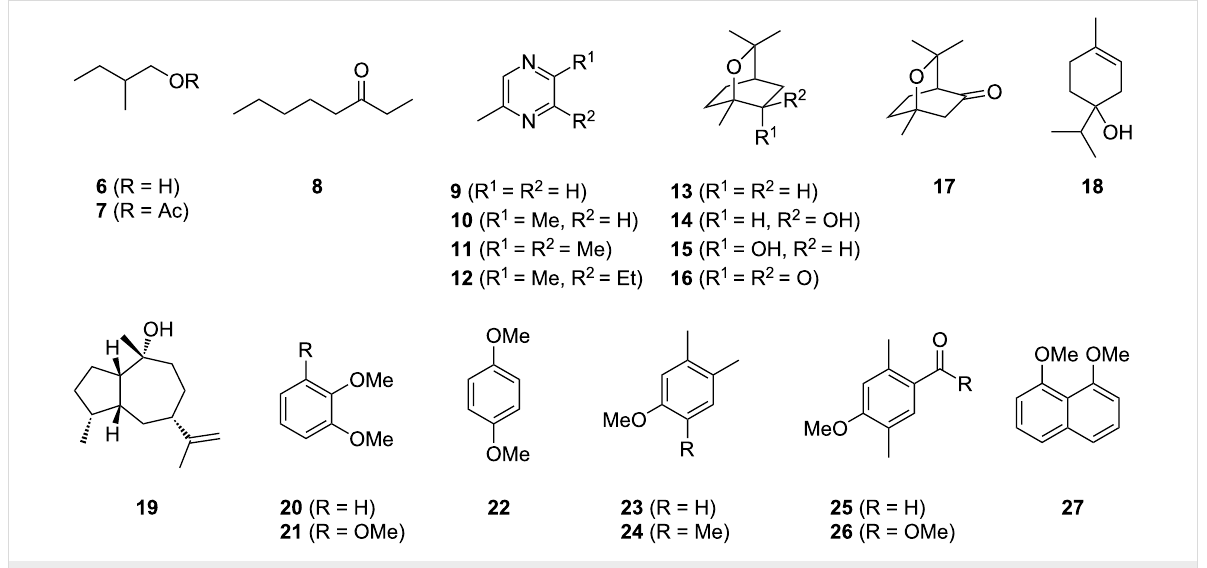
Figure 3: Volatiles from Hypoxylon griseobrunneum